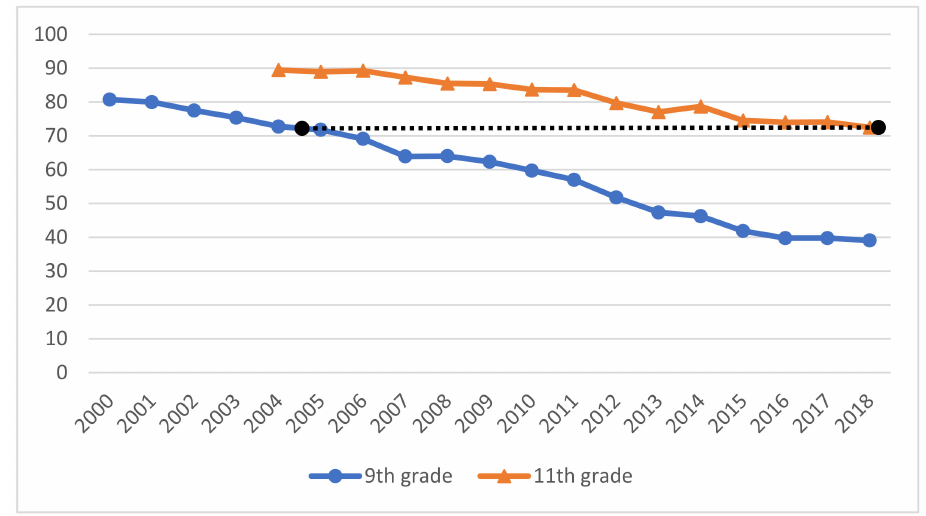
Figure 1. Prevalence of alcohol consumers in year 9 and year